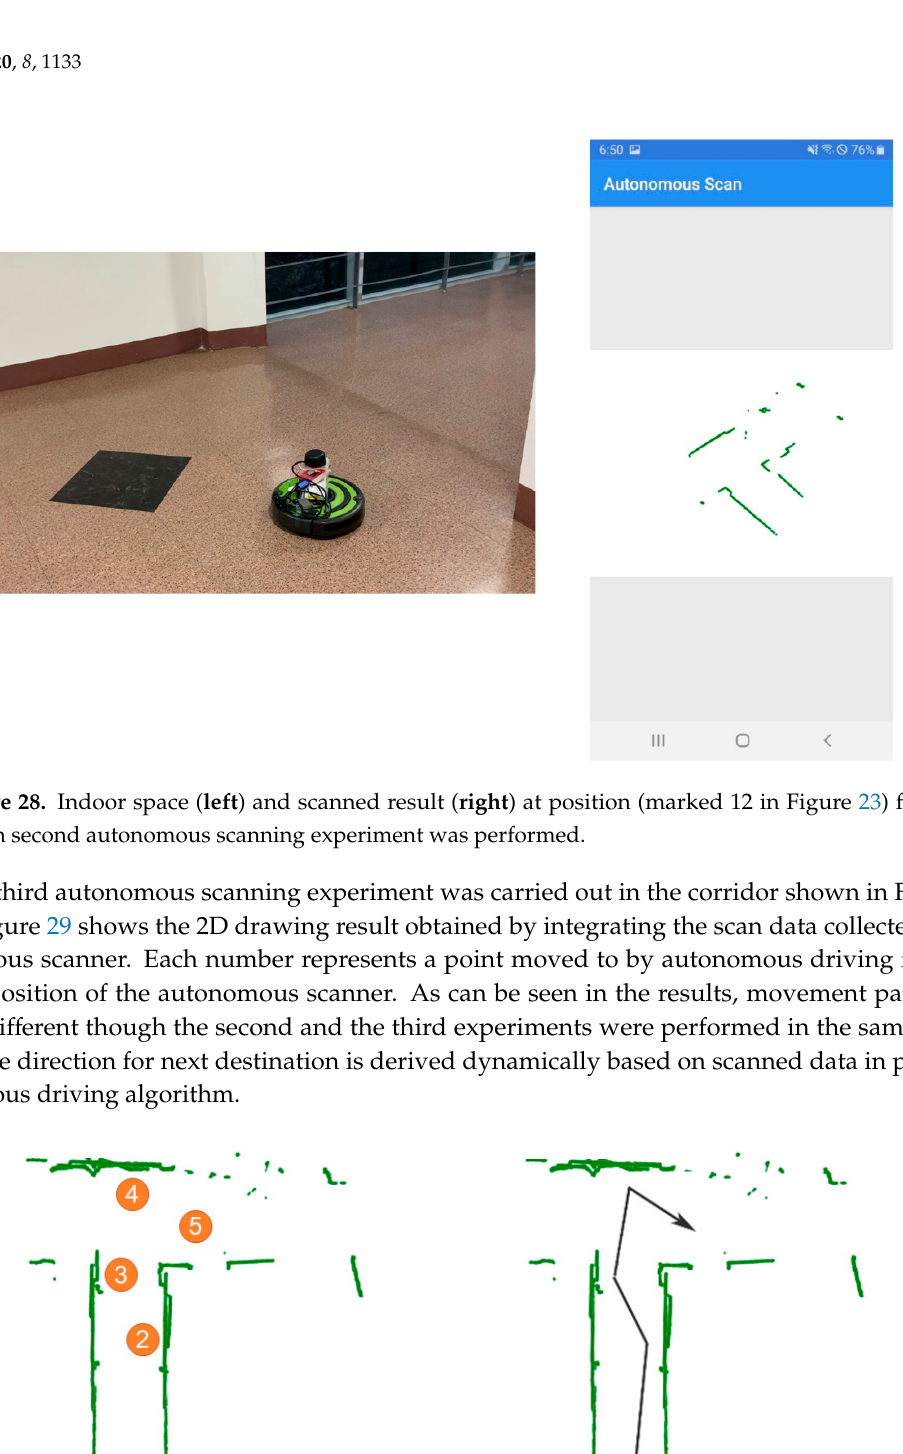
21 of 29 Figure 27. Environmental data result ( left ), captured image ( middle ), and scanned result ( right ) at